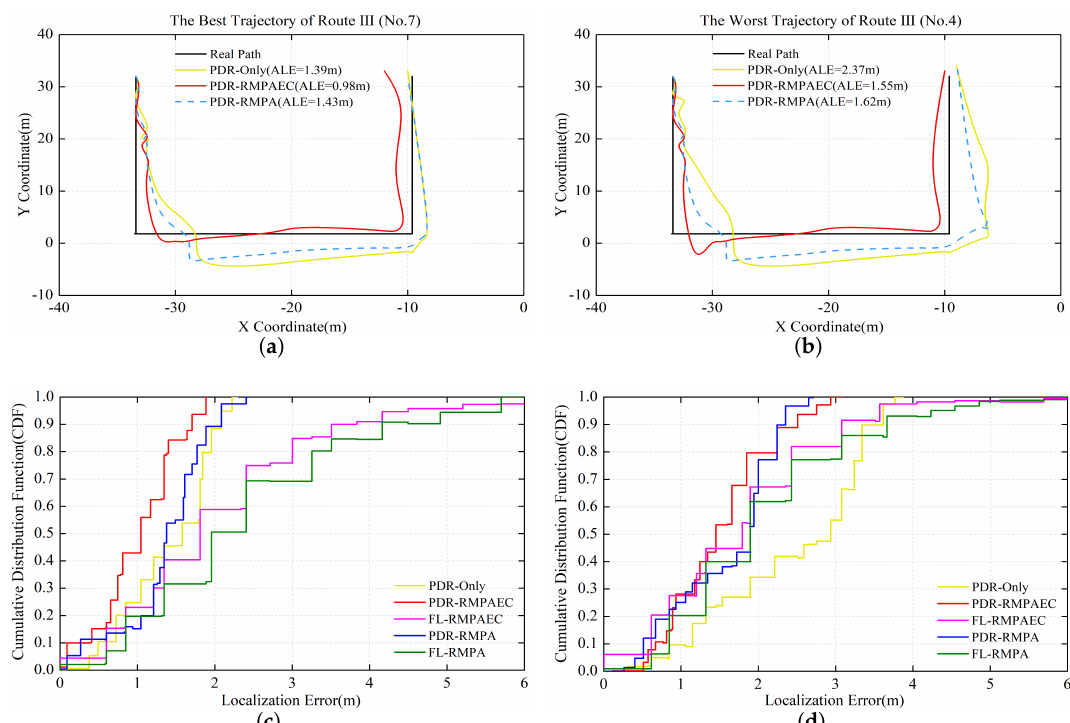
Figure 10. Localization results in Route III: ( a ) the best No. 7 PDR-RMPAEC trajectory with ALE = 0.98 m; ( b ) the worst No. 4 PDR-RMPAEC trajectory with ALE = 1.55 m; ( c ) CDF of localization error of the No. 7 trajectory; and ( d ) CDF of localization error of the No. 4 trajectory.